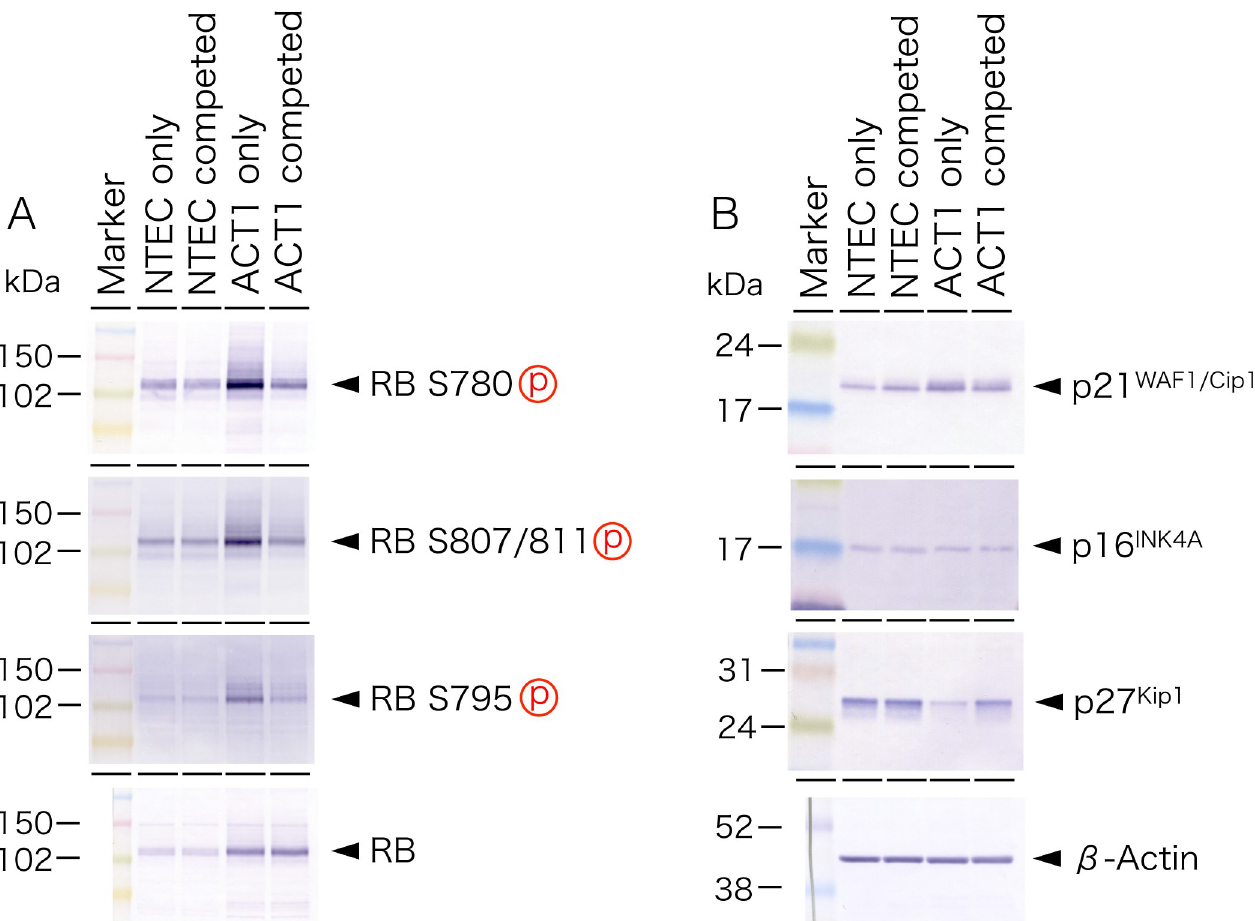
Fig 7. Western blot analysis of RB and CKIs. Total protein was extracted from both NTECs and ACT1 cells cultured either alone (NTEC or ACT1 only, respectively) or from cell co-cultures (NTEC or ACT1 competed, respectively) and subjected to western blot analysis with indicated